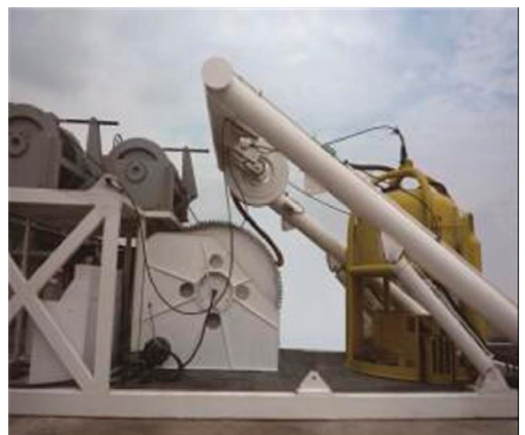
Figure 15: YH25 wave compensation